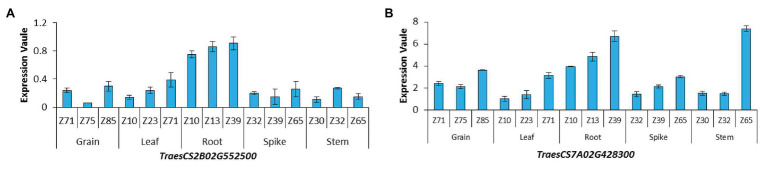
Expression patterns of genes in different wheat organs at three growing stages (A)
TraesCS2B02G552500; (B)
TraesCS7A02G428300; z10, first leaf through coleoptile; z13, three leaves unfolded; z23, main shoot and three tillers; z30, pseudostem erection; z32, second detectable node; z39, flag leaf ligule and collar visible; z65, 1/2 of flowering complete; z71, kernel (caryopsis) watery ripe; z75, medium milk; z85, soft dough.